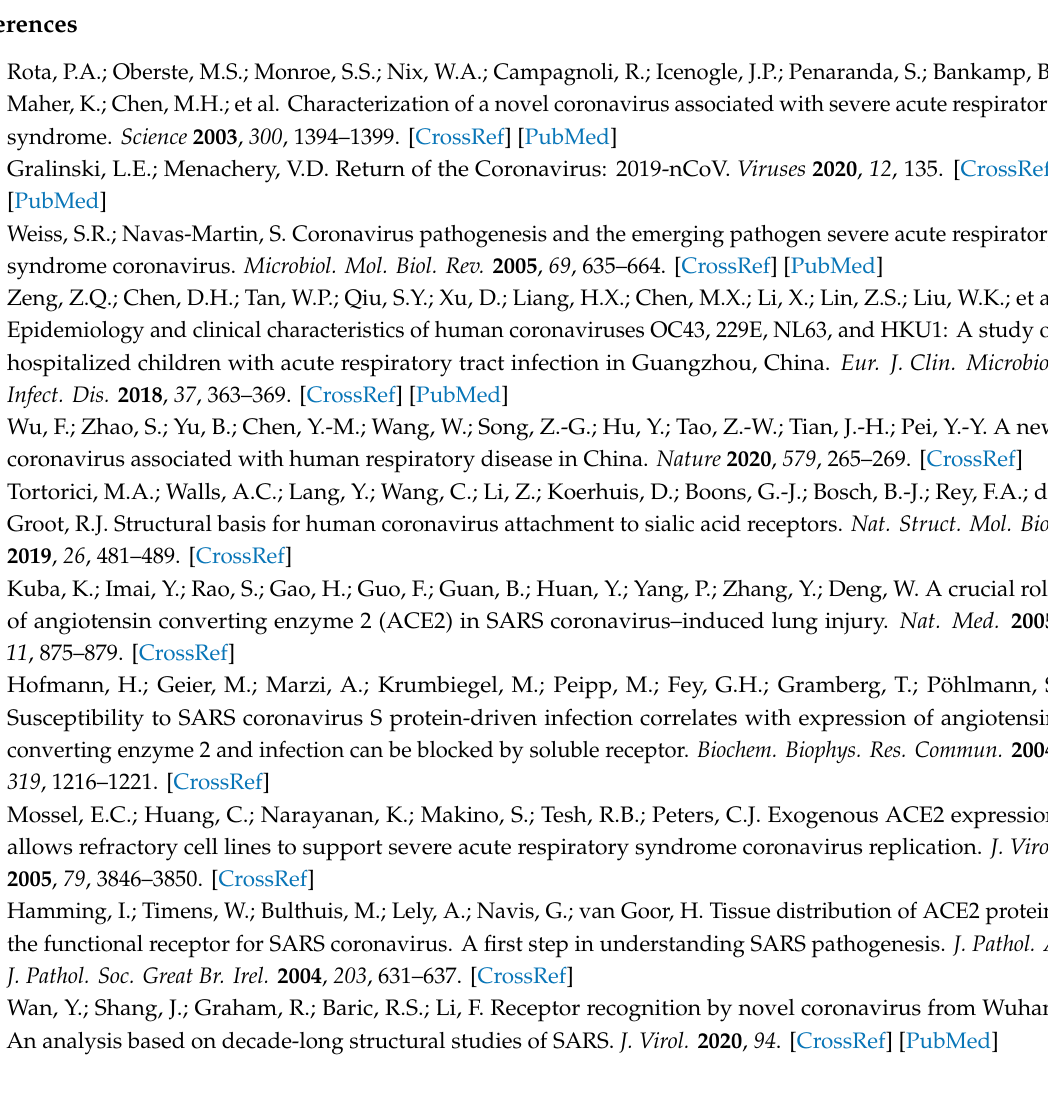
Figure S1: Comparison between the X-ray structure of COVID-19—ACE2 complex; Figure S2 Multiple sequence alignment of the analyzed RBDs; Figure S3: RBD—ACE2 interaction scores and contacts, Table S1: RBD interface residues that have substitutions between COVID-19 and SARS-2002; Table S2: Table S2. RBD—ACE2 interface evaluated by several methods for analysis of protein-protein interactions, Video S1: Overlay of 50 random snapshots from the MD trajectories of COVID-19—ACE2, SARS-2002—ACE2, and HCoV-NL63—ACE2 complexes. For clarity only one copy of ACE2 is shown (gray), COVID-19, SARS-2002, and HCoV-NL63 are colored blue, red, and green,